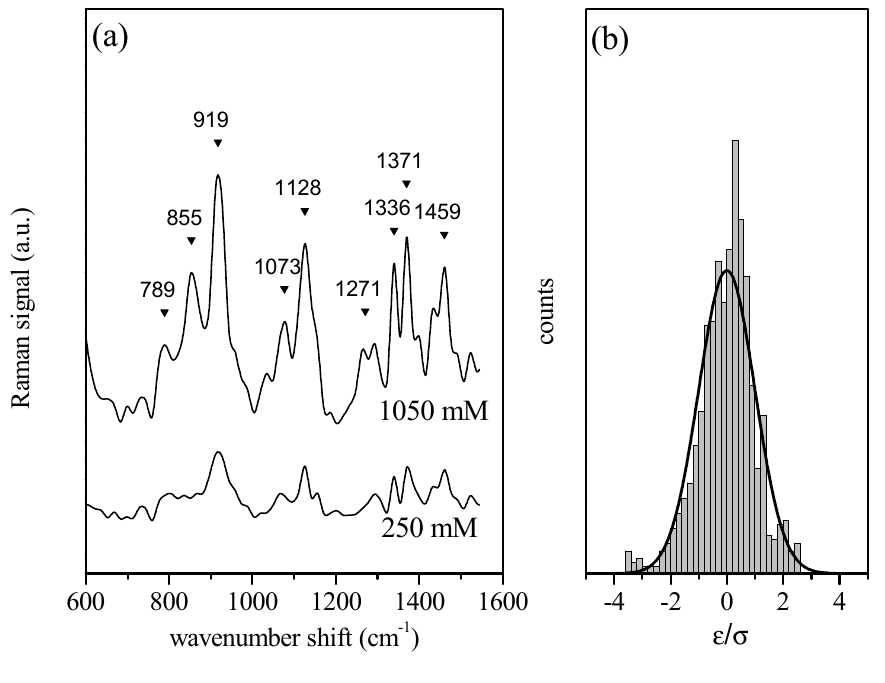
Figure 1. (a) Raman spectra (600–1,600 cm − 1 spectral region) of aqueous glucose solutions at two different glucose concentrations (1,050 mM and 250